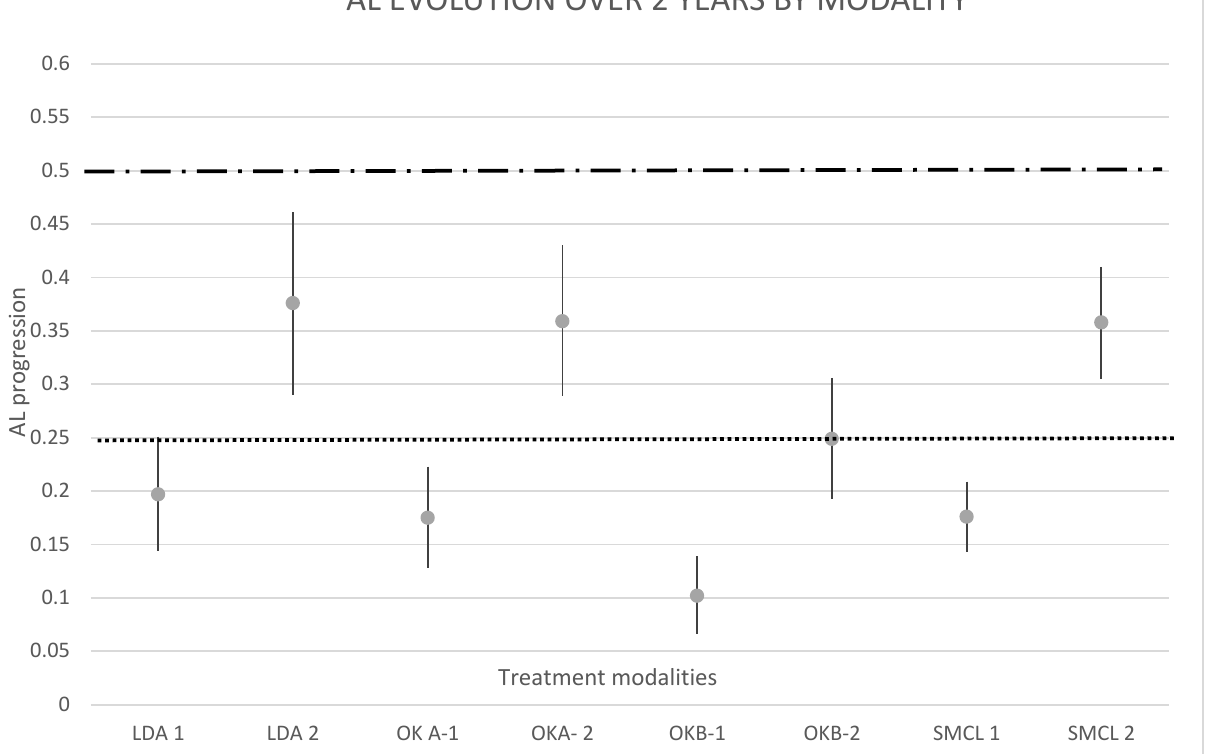
Figure 2. LDA: low dose atropine, year 1 (LDA1) and 2 (LDA2). OKA: large treatment zone (OrthoK1 lens), year 1 (OKA-1) and 2 (OKA-2). OKB: smaller treatment zone (OrthoK2-3-4 lenses), year 1 (OKB-1) and 2 (OKB-2). All soft multifocal contact lens combined, year 1 (SMCL1) and 2 (SMCL2). Reference lines: points: average 1 year progression-control; bar/points: 2 years progression-control.